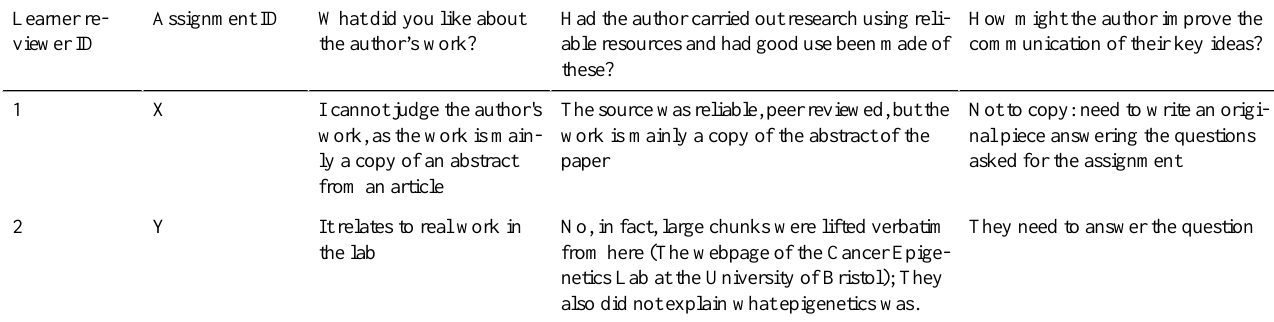
Table 6. Summary of learners’responses to their peers’plagiarized assignments in Run 1. The Learner Reviewer ID and the Assignment ID have been renamed to ensure anonymity. The 3 questions used to scaffold the peer reviews are shown alongside the learners’answers to these questions.